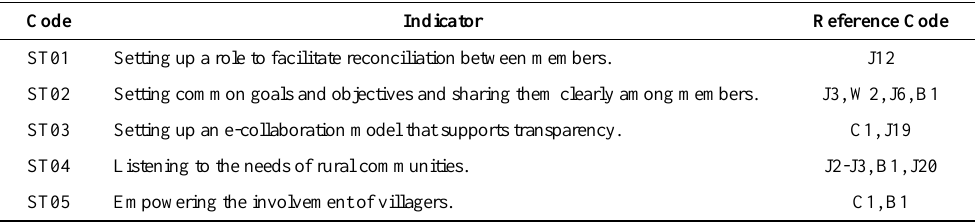
Table 7. The ST Strategy (The Strength-Threat